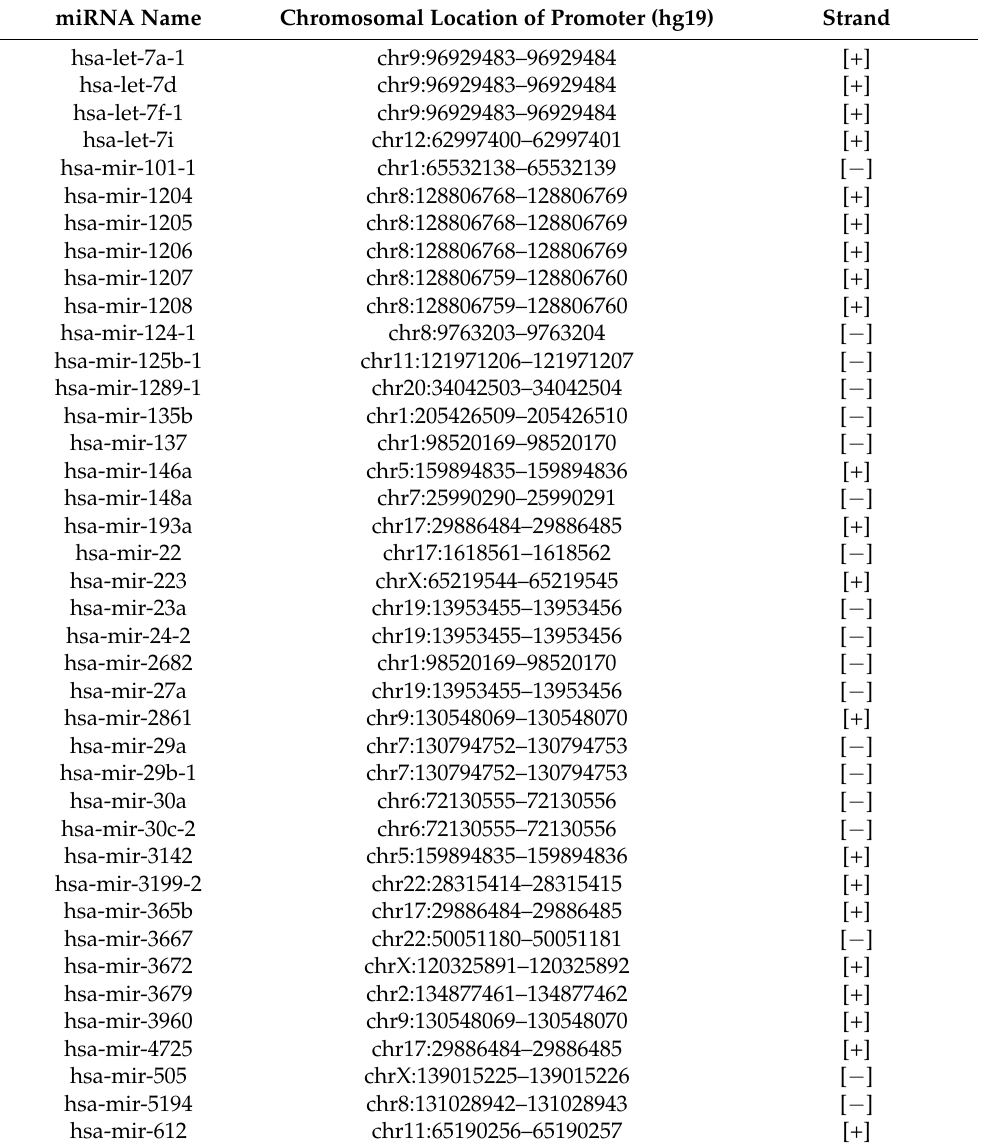
Table 1. MiRNAs containing experimentally verified NF- κ B binding sites in their promoter (miRGen v3.0